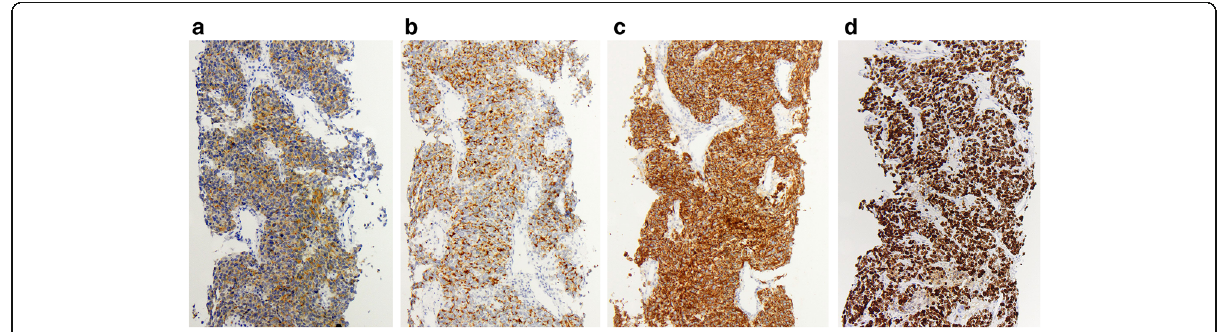
Fig. 2 Immunohistochemistry a Synaptophysin [100x], b Chromogranin [100x], c AE1/AE3 [100x], d Ki-67 labeling index